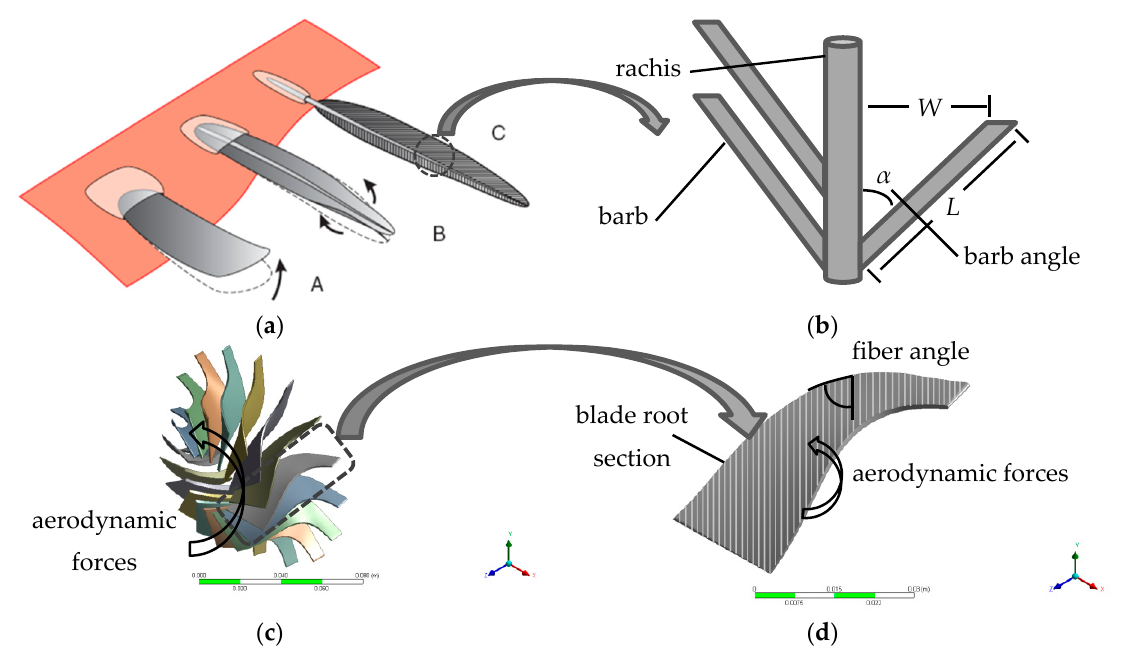
Figure 1. ( a ) Three stages in the development of flight feathers from simple scales in birds [12]: (A) a simple scale tends to bend upwards in response to air pressure, (B) a longitudinal stiffening ridge resists upward bending, and (C) stiffening ridges in the vanes resist the curling tendency. ( b ) Schematic diagram of the mature feather branch morphology: vane width (W), barb length (L), and barb angle with respect to the rachis ( α ). ( c ) Geometry of the rotor blades for a radial inflow turbine and ( d ) schematic diagram of the proposed fiber orientation inspired by bird feathers.